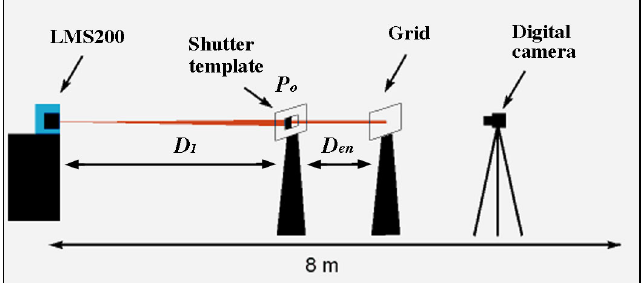
Figure 7. Test set-up to study the function: D